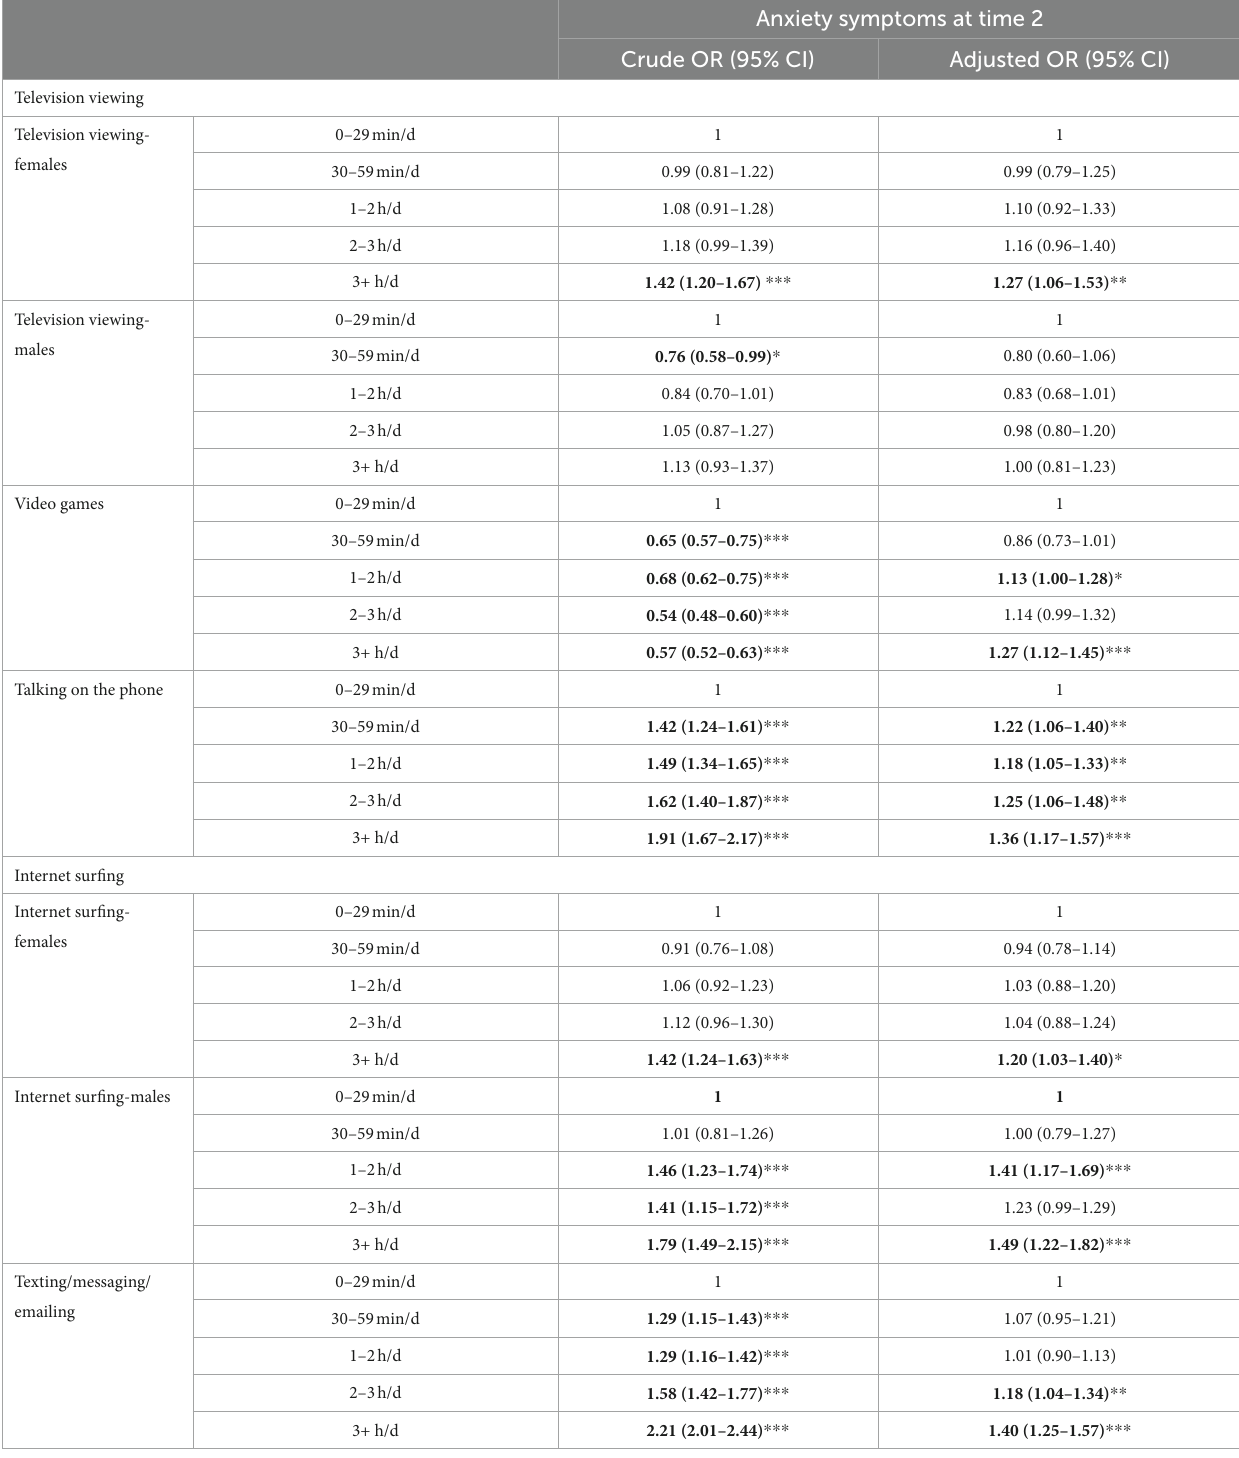
Bold values represent statistically significant results. OR, odds ratio; CI, confidence interval. Models are adjusted for school clustering, age, race/ethnicity, BMI z -score, income, and prior year anxiety. * p < 0.05; ** p < 0.01; *** p < 0.001. Data from Canadian secondary school students linked across year 6 (2017–18) and 7 (2018–19) of the COMPASS